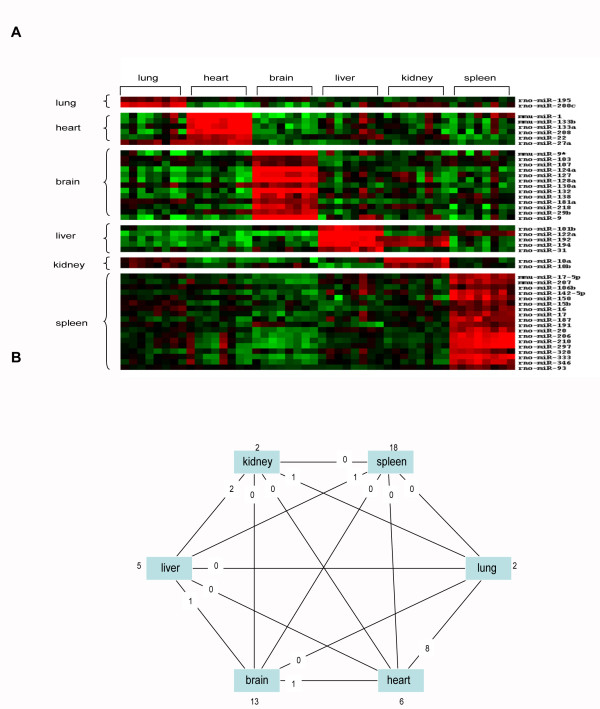
Organ-specific microRNAs. (A) Hot maps. The microRNA samples from 6 organs were co-hybridized with the common reference. The signals were processed as described in Materials and Methods. The normalized data were subjected to the SAM test [67]. The miRNAs that passed SAM were further tested by the HSD test (P < 0.05) to identify organ-specific miRNAs. Each column represents one hybridization and each row represents one miRNA. The figure was drawn by Treeview. Red represents positive values, green negative values, and black zero. The number of miRNAs for each organ is: Lung 2; heart 6; brain 13; liver 5; kidney 2 and spleen 18. (B) Summary of differently expressed miRNAs among 6 organs. The number beside each organ represents the number of miRNAs that are expressed significantly higher in this organ than any other organs (P < 0.05). The number on the line between any two organs is the quantity of miRNAs expressed significantly higher in these two organs than in other organs (P < 0.05).